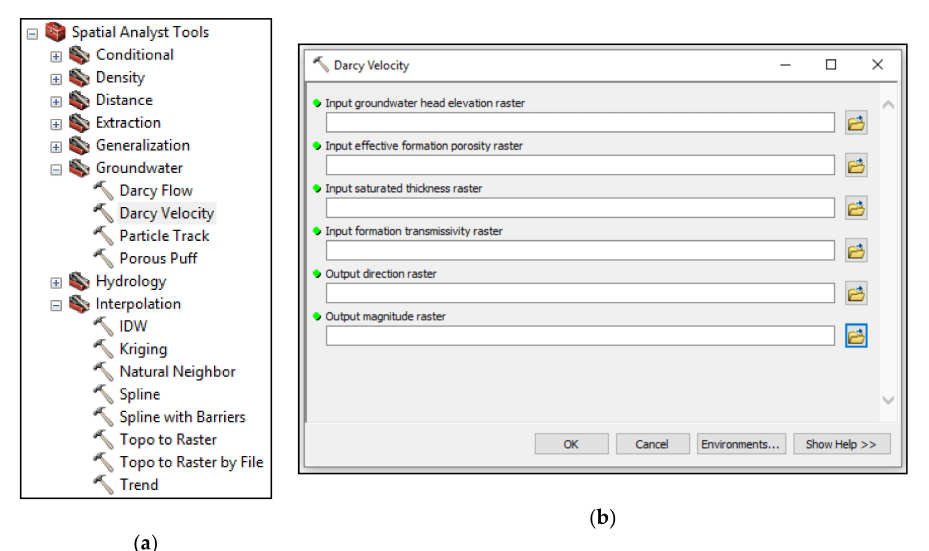
Figure 6. ArcMap / Geographic Information System (GIS) tools used: ( a ) interpolation; ( b ) Darcy velocity interface